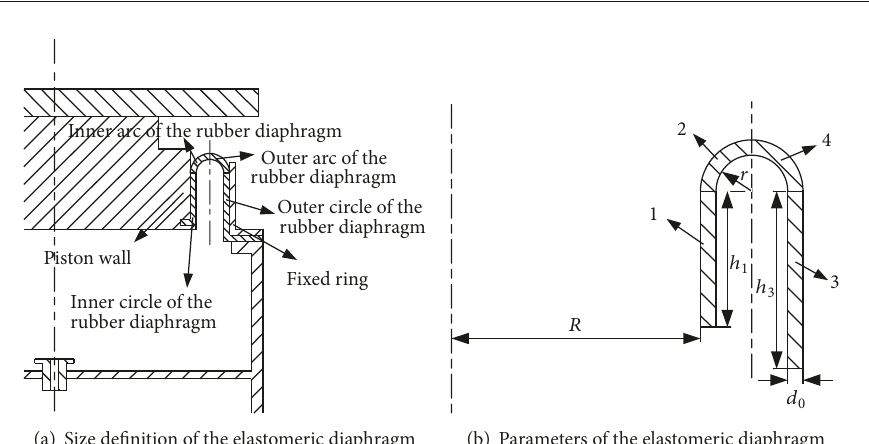
Figure 2: Elastomeric